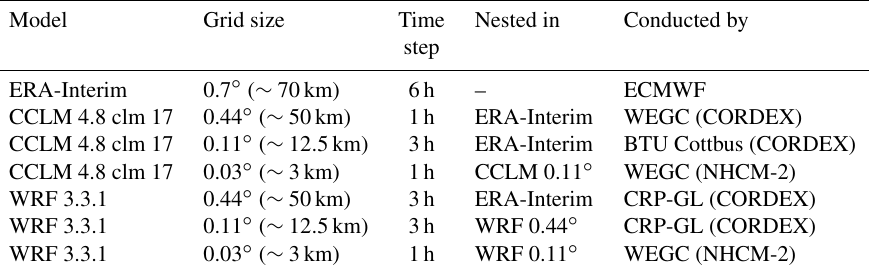
Table 2. RCMs and their settings. Model Grid size Time Nested in Conducted by ERA-Interim 0.7 ◦ ( ∼ 70km) – ECMWF